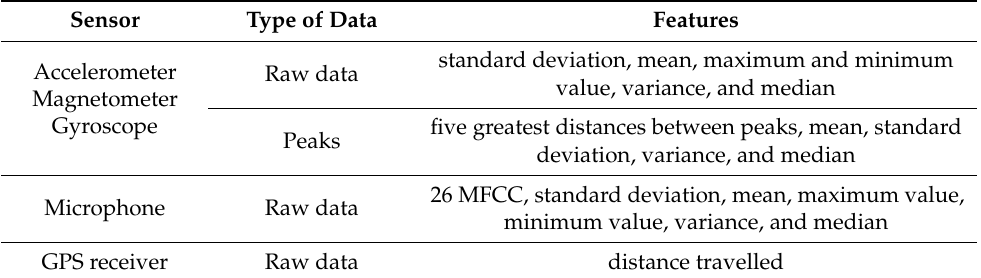
Table 1. Features